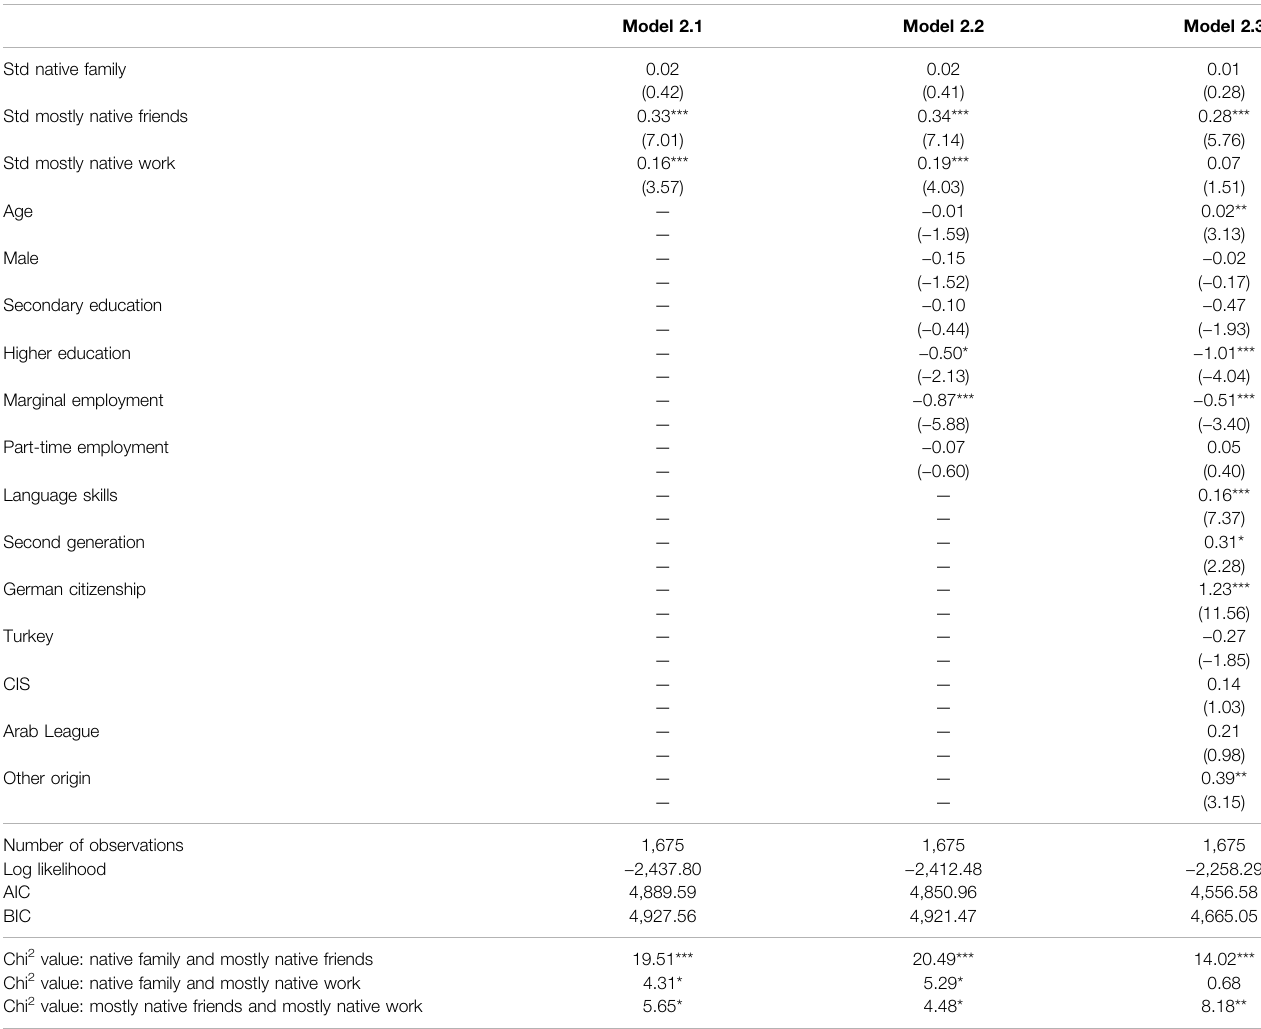
TABLE 2 | Lagged ordered logit